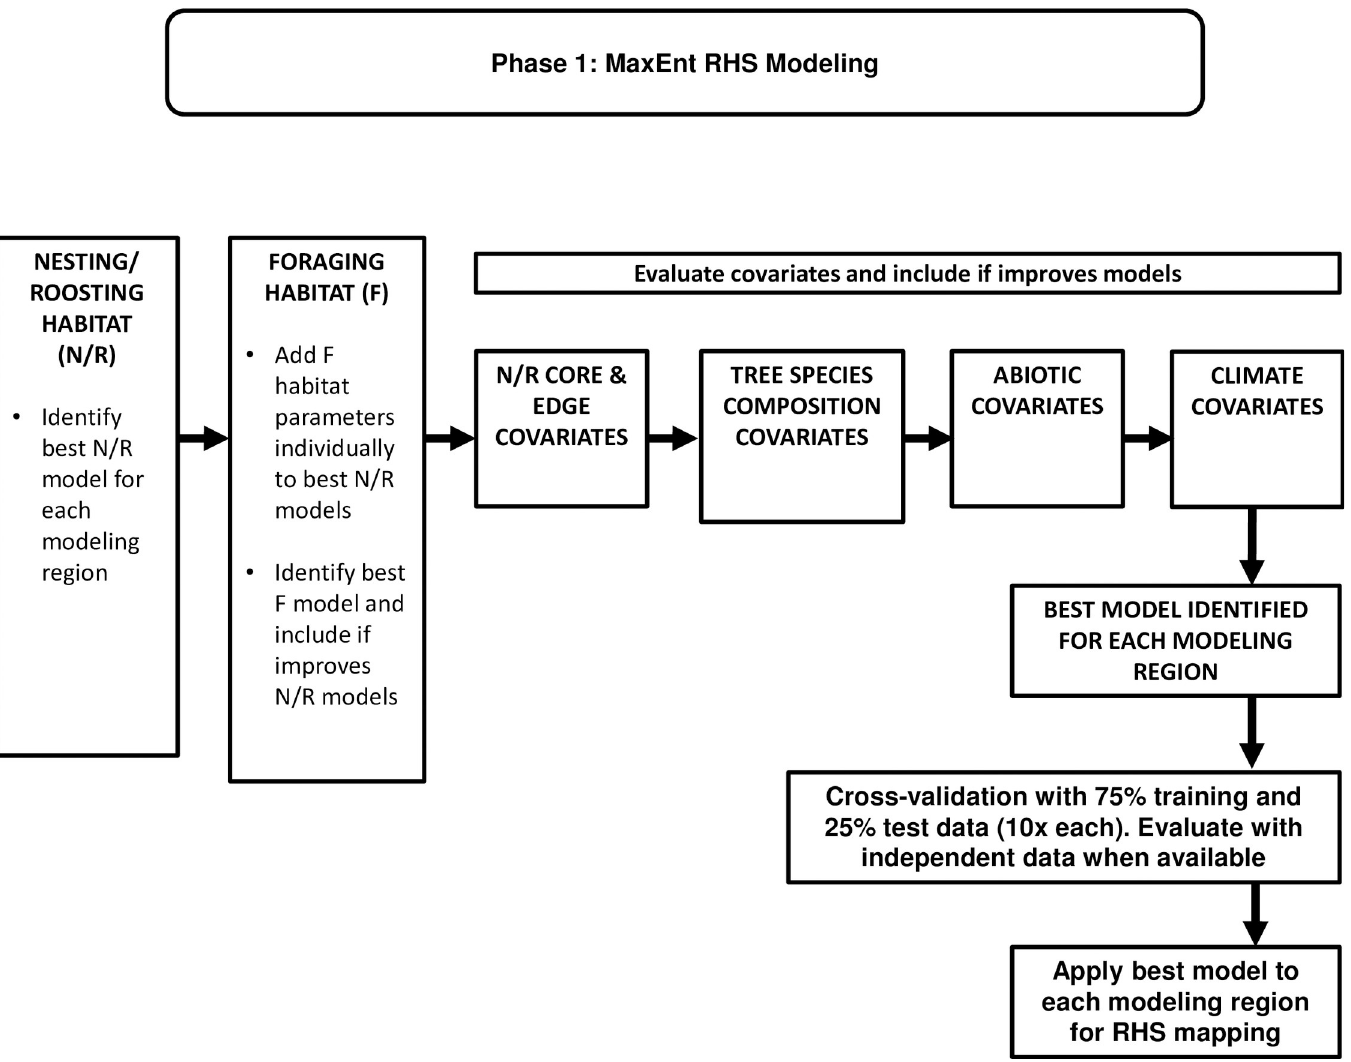
Fig 3. Flowchart of development and evaluation of MaxEnt relative habitat suitability (RHS) models within each of 11 modeling